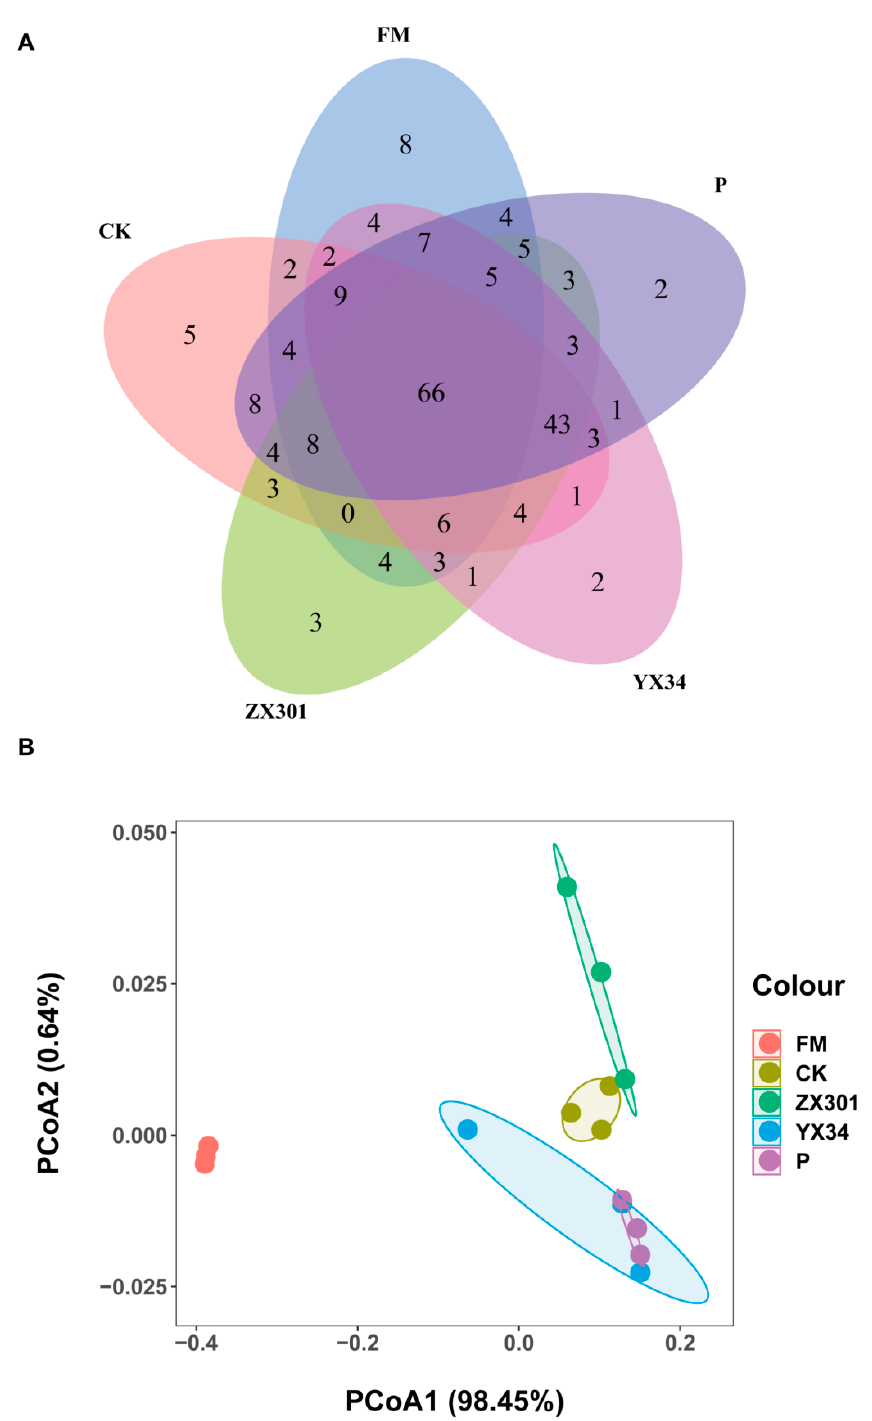
Figure 1. Microbial community of FM and Stipa grandis on 60 days of ensiling ( n = 3): ( A ) Venn diagram representing the common and unique operational taxonomic units (OTUs) of FM and Stipa grandis on 60 days of ensiling. ( B ) Principal coordinates analysis (PCoA) of samples conducted based on weighted UniFrac distance. FM, fresh matter; CK, control group; ZX301, pediococcus pentosaceus - treated group; YX34, lactobacillus planturum -treated group; P, a commercial inoculant-treated group containing lactobacillus plantarum .